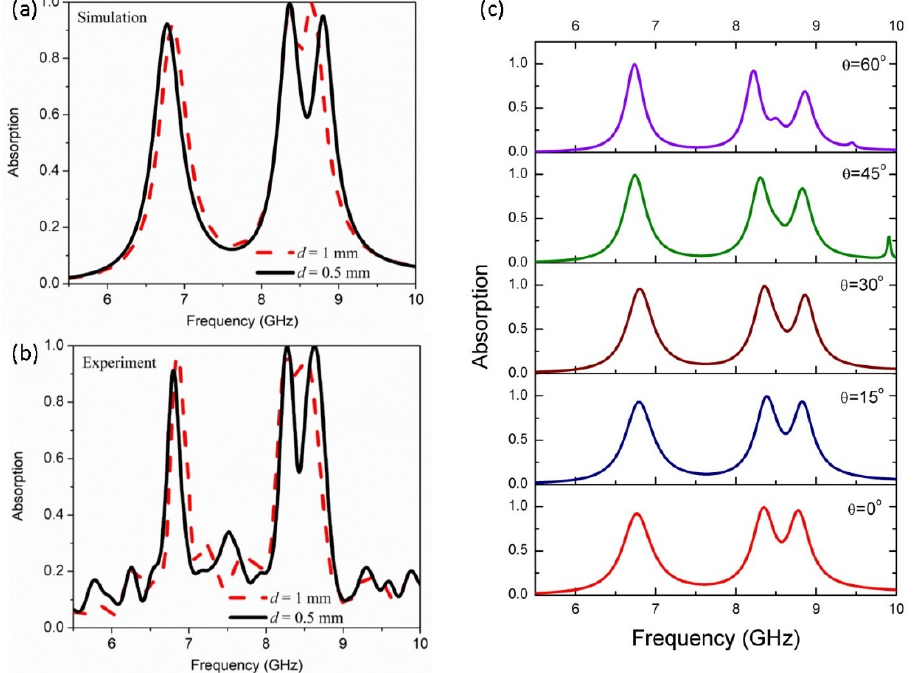
Figure 3. Dependences of ( a ) simulated and ( b ) measured absorption spectra on the distance d between SRR and CS structures and ( c) dependence of the absorption spectrum on the incidence angle.